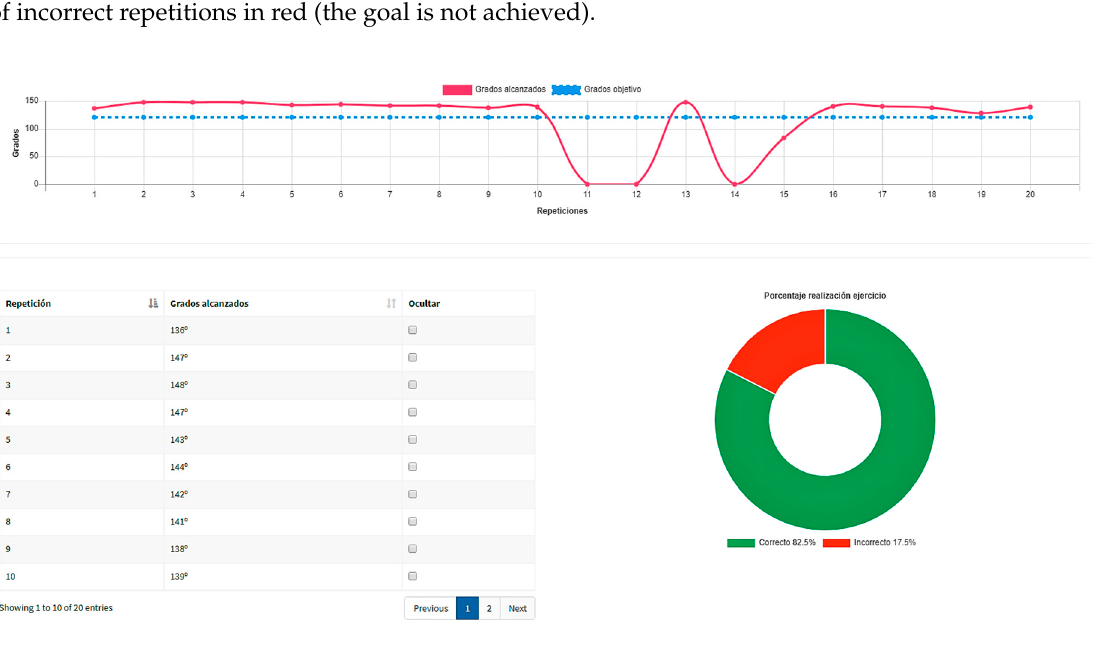
Figure 5. A report of a series of 20 repetitions of a concentric exercise.